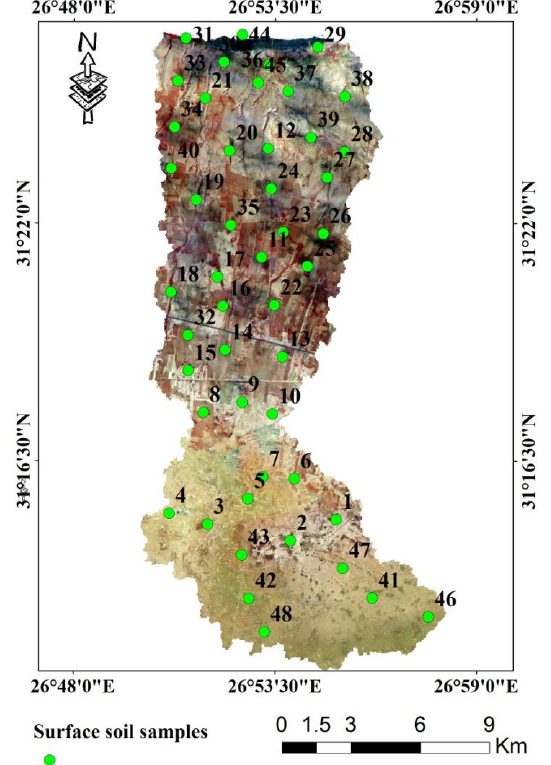
Figure 6. Distribution of surface soil samples within the study area.